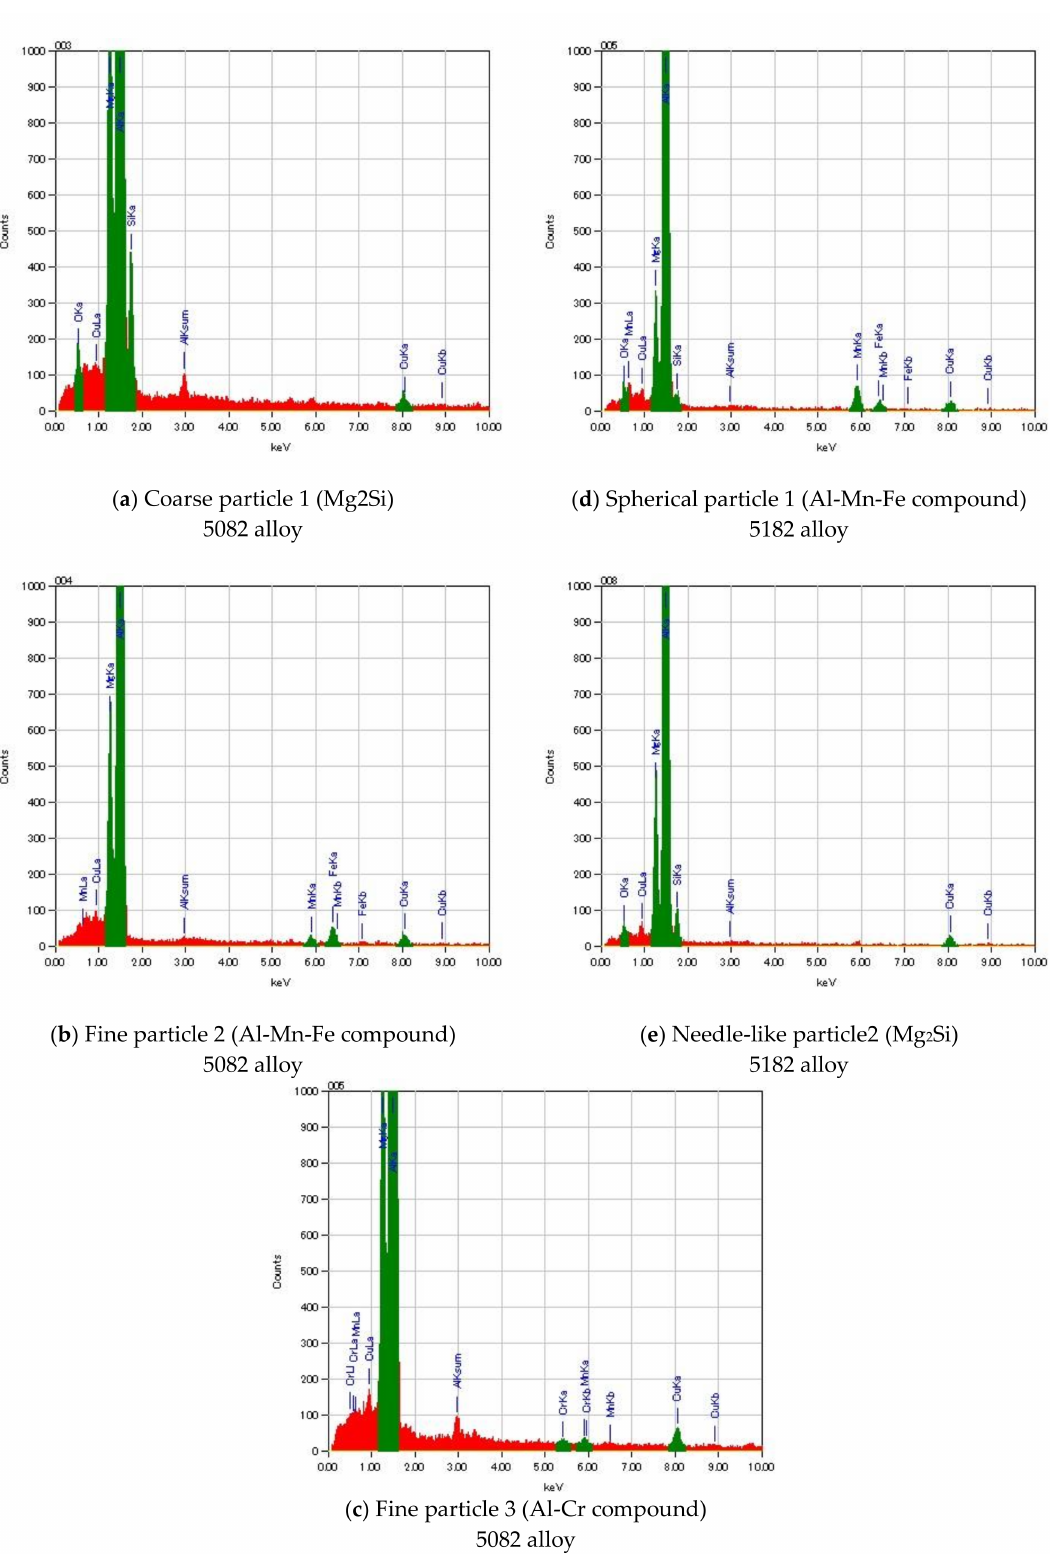
Figure 10. EDS analysis of particles for 5082 and 5182 alloys in Figure 9. ( a ) Coarse particle 1 (Mg 2 Si) in 5082 alloy, ( b ) Fine particle 2 (Al-Mn-Fe compound) in 5082 alloy, ( c ) Fine particle 3 (Al-Cr compound) in 5082 alloy, ( d ) Spherical particle 1 (Al-Mn-Fe compound) in 5182 alloy, ( e ) Needle-like particle2 (Mg 2 Si) in 5182